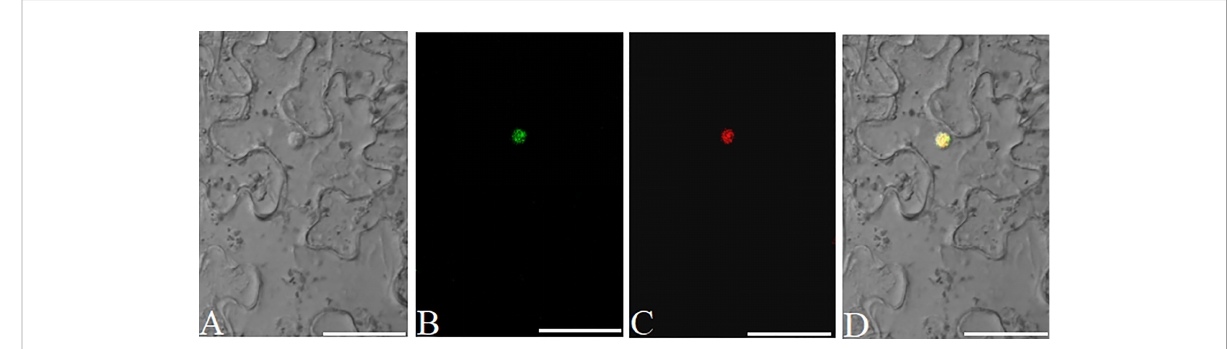
FIGURE 8 Analyses of the subcellular localization of VvCEB1 opt in N. benthamiana leaf cells using the pK35BTR2GFP vector. Bright fi eld (BF) (A) . Fluorescent signal of VvCEB1opt-eGFP fusion protein (B) . Subcellular localization of nucleus markers using mCherry fl uorescent protein (mChe) (C) ; Merge: overlapping of the eGFP, mChe, and BF images (D) . Scale bars=50 m